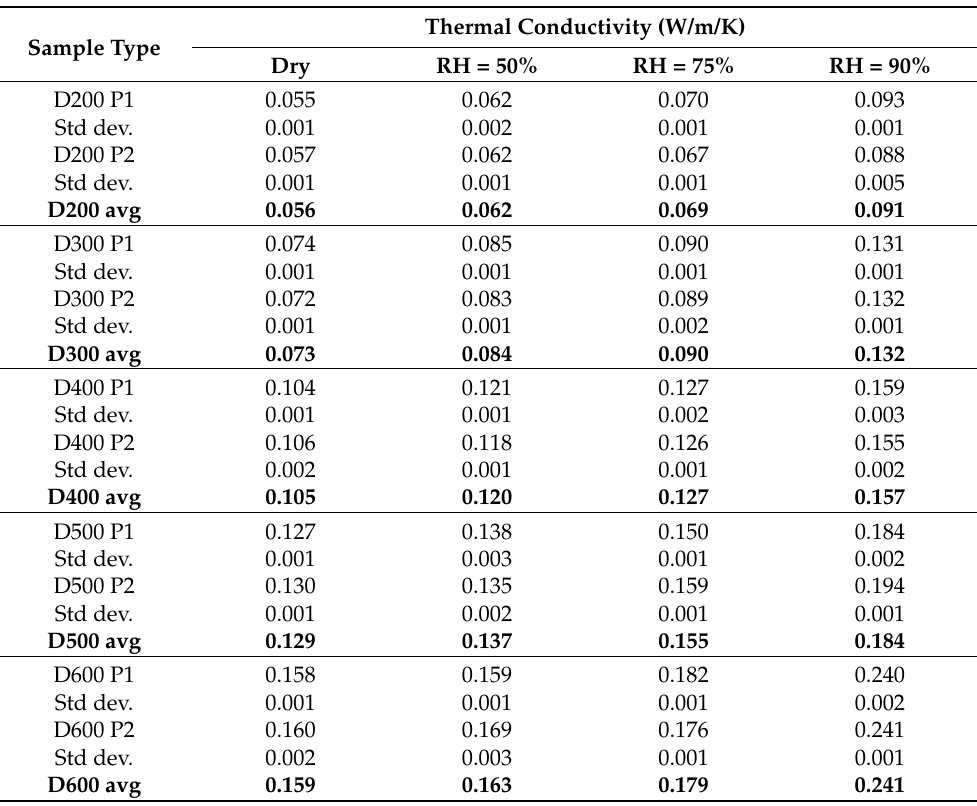
Table 2. Thermal conductivity of measured samples at different relative humidities (P1 and P2 denote samples of the same